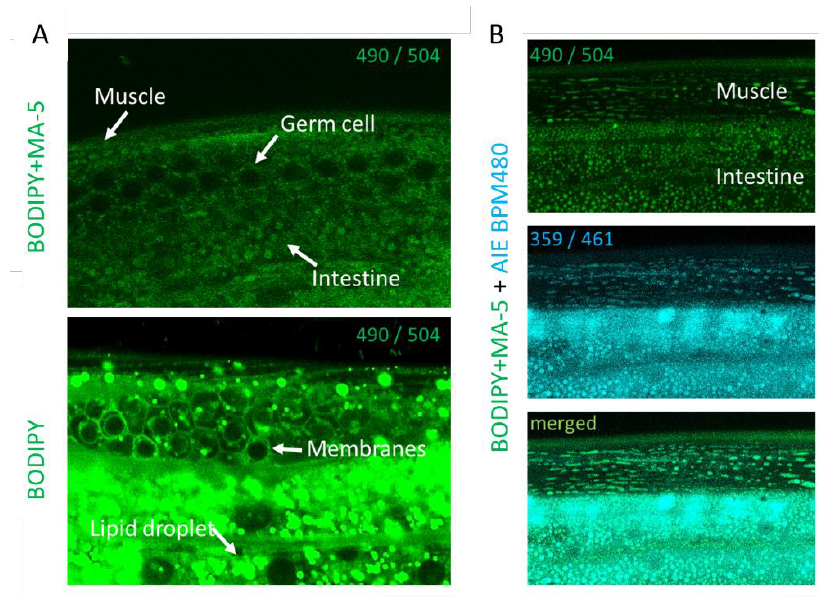
Figure 1. Penetration and homing activity of MA-5 into intact C. elegans mitochondria. ( A ) Differences between BODIPY-MA-5 and BODIPY. Fluorescent signals of BODIPY-MA-5 on mitochondria are indicated in muscle, germ cell and intestine (white arrows). BODIPY staining signals show in intestinal lipid droplets and germ cell membranes. ( B ) The z-stack images of body wall muscle cells of wild-type (N2) adults on day 2 were monitored by confocal microscopy. Localization of MA-5-BODIPY in mitochondria (indicated as green), Mitochondrial Maker AIE mitochondria blue (indicated as blue) and merged image demonstrating mitochondrial localization (indicated as cyan). Fluorescent excitation and emission wavelengths (nm) are indicated as numbers in each picture excitation⁄ emission (nm). Scale bars represent 10 µm. Table 1. Median lifespan of ATU3301 animals a treated with